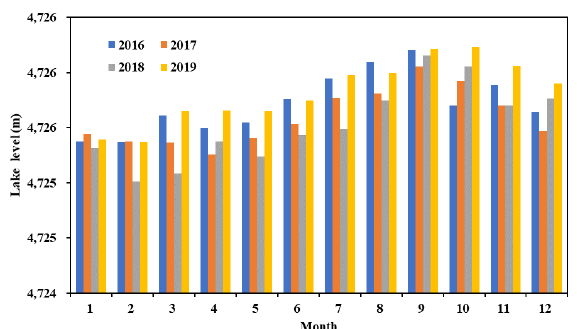
Figure 6 . Time series of lake levels during 2010-2020.